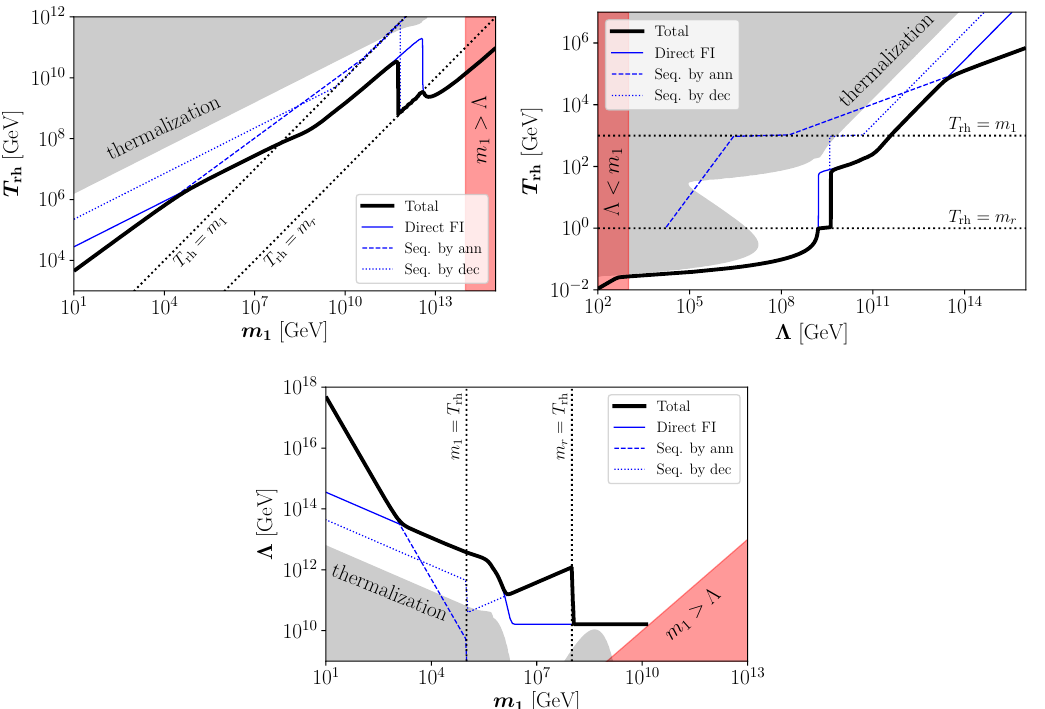
Figure 5 . Reheating temperature required to reproduce the experimentally observed DM abun- dance, (cid:10) (cid:31) h 2 , for m (cid:31) = 1 MeV, taking into account all possible DM production mechanisms (thick black lines). Upper left panel: T rh as a function of m 1 for (cid:3) = 10 14 GeV; upper right panel: T rh as a function of (cid:3) for m 1 = 10 3 GeV; Lower panel: correlation between (cid:3) and m 1 for T rh = 10 5 GeV. In all panels, m r = m 1 = 10 3 , whereas as always the gray- and red-shaded areas are the regions where chemical equilibrium with the SM is reached and where the EFT approach breaks down, respectively. The two black-dotted lines represent the conditions T rh = m 1 and T rh = m r . The light blue solid, dashed and dotted lines represent the contributions from direct freeze-in, sequential freeze-in via annihilation and sequential freeze-in via inverse decay, respectively (as explained in the